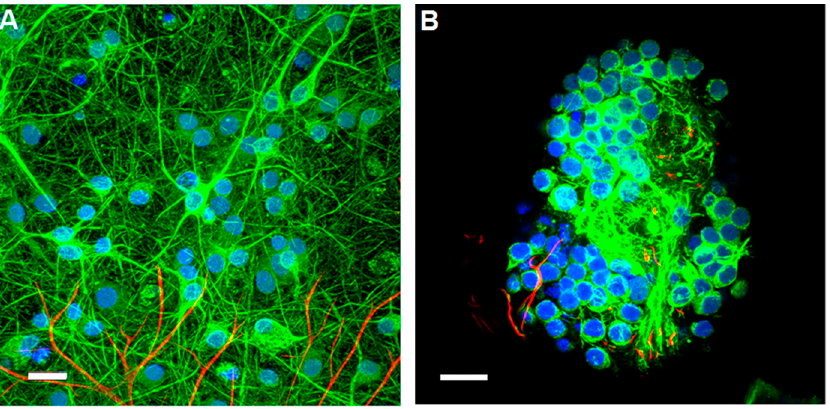
Figure 5. Adhesion and growth of 17-day rat embryo hippocampal neurons and glial cells on ( A ) NCD substrates coated with an adhesion-promoting layer of poly-D-lysine and laminin, and ( B ) virgin NCD substrates, as shown by confocal microscopy images with immunostaining. Cells were stained with anti-neurofilament antibodies (NF, giving neurons a fluorescent green colour), 4 ′ ,6-diamidino-2-phenylindole (DAPI, marking the DNA-rich nucleus of neurons with blue) and antibodies for glial fibrillary acidic protein (anti-GFAP, making glial cells appear in red). In each image, scale bar = 20 µm. Adapted from Ojovan et al. [41] under a creative commons licence.